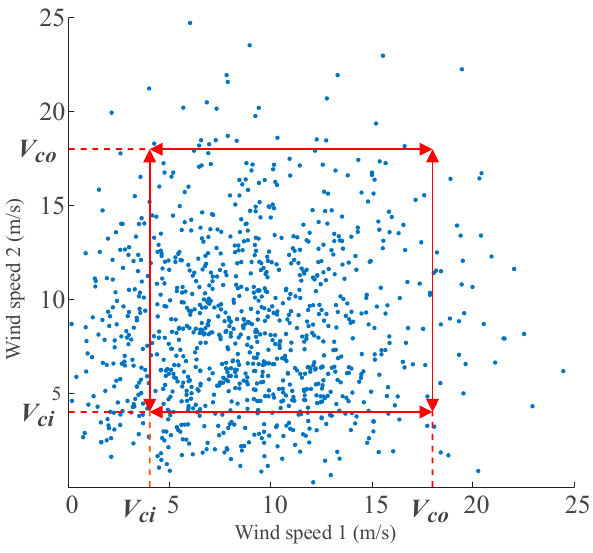
Figure 1. Samples of wind speeds.